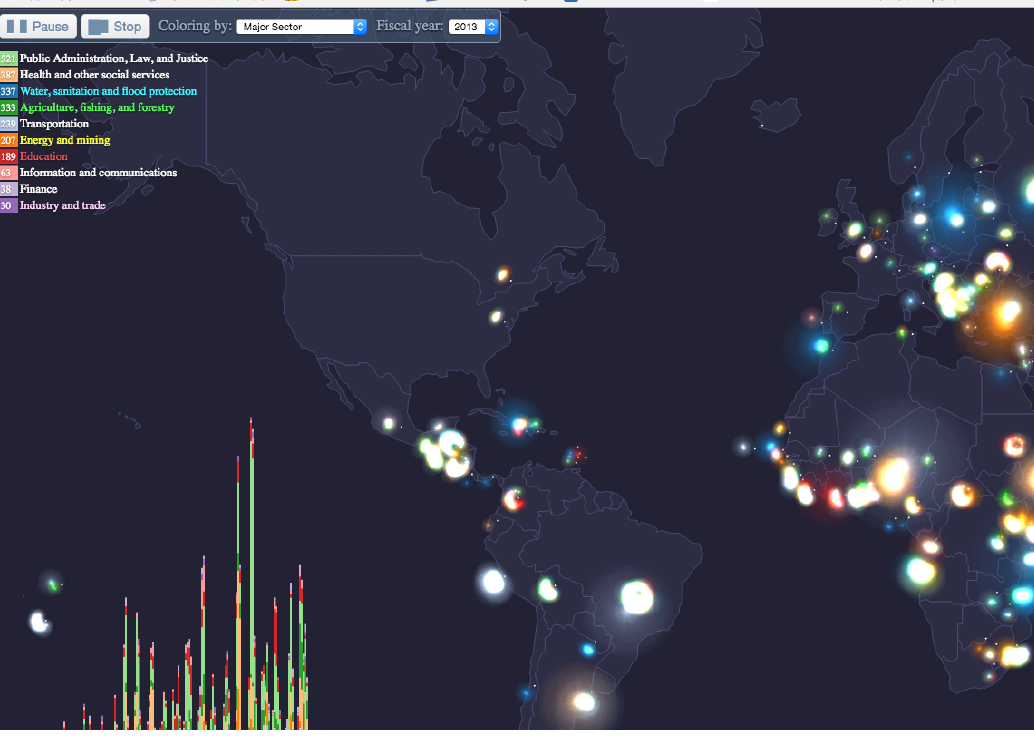
Figure 20. Some samples to show the messy form of